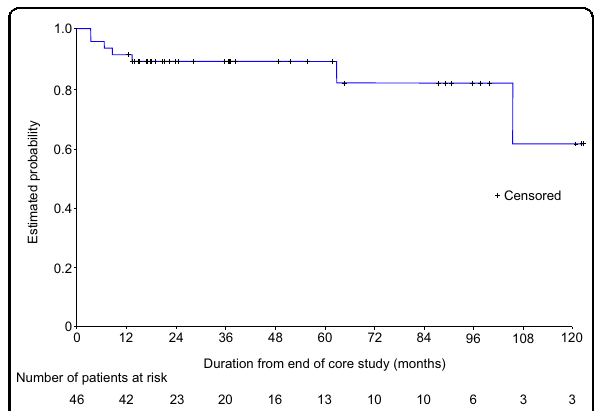
Fig. 2 Time to treatment failure of responders (according to revised clinico-hematological ELN criteria) (ITT Population). The X axis is the duration from the end of the core study (in months), and not visits. Note that as this is an ongoing study, patients currently in the study have received varying durations of therapy. At the time of these analyses, 31 patients were still in the